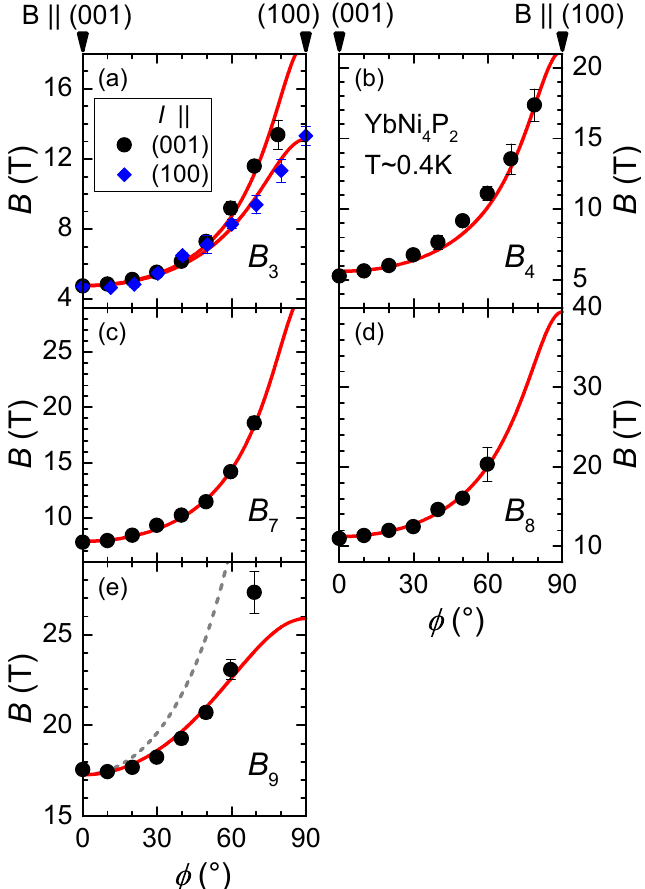
Figure 3: Magnetic anisotropy in YbNi P . (a)-(e) The position of the LTs identified 4 2 from ρ (black circles) (cf. Fig. 2) and ρ (blue diamonds) (cf. Fig. 4) are presented zz xx together with uncertainty weighted least square fits using eq. 1 (red solid lines). For B only a poor fit could be obtained as shown by the red line in (e) corresponding 9 to η = 1.5. The dashed grey line in (e) represents the expected angular dependence for η = 3 fixed to the position of B at φ = 0. 9